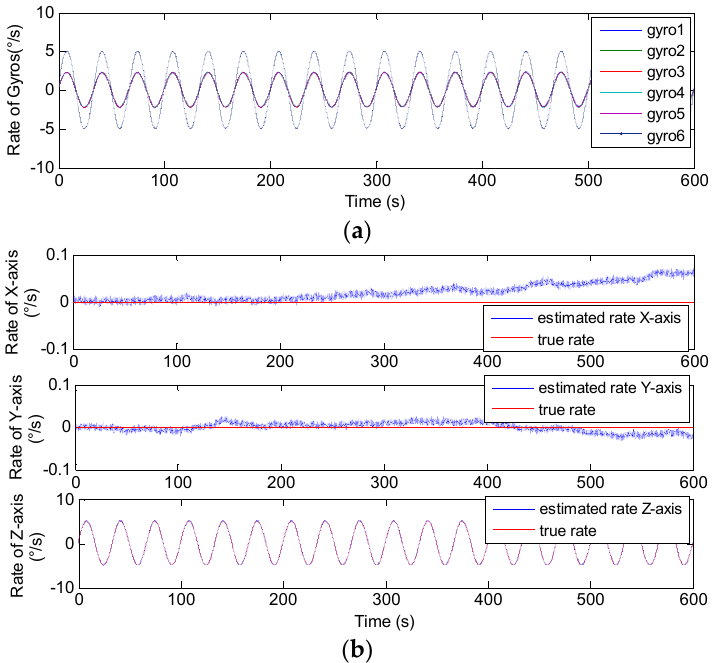
Figure 18. Sinusoidal results of the 6-gyro MIMU system for scheme 2. ( a ) The outputs of the gyros. ( b ) The estimated results of the MIMU.